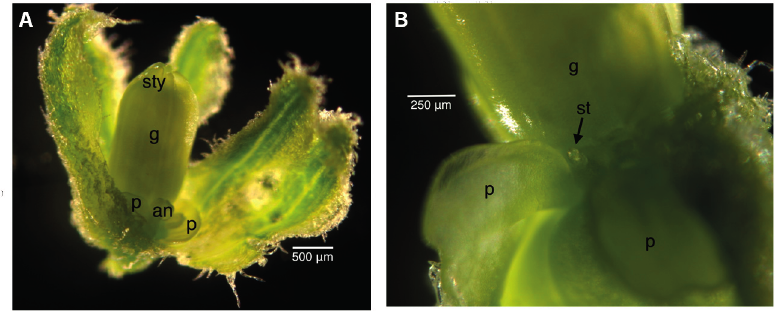
Figure 9. Stage 10 of female infected ( A ) and uninfected ( B ) floral buds where the styles start to appear. In the infected bud, the anthers continue to develop, while the stamen in the uninfected bud becomes rudimentary. Size bars, approximately 500 and 250 µm, respectively, in ( A , B ). sty, styles; g, gynoecium; p, petal; an, anther; st,